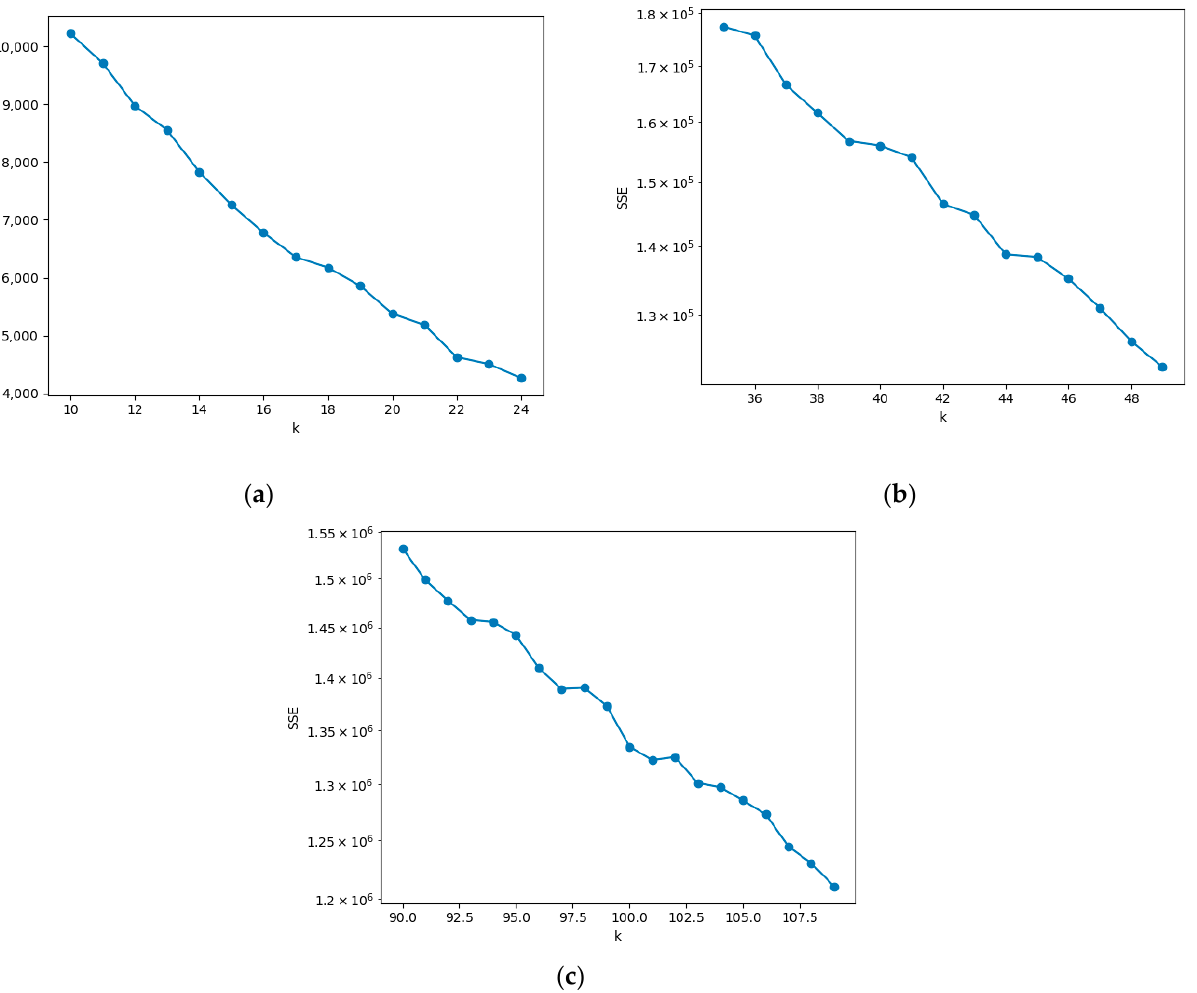
Figure 8. The Elbow method determines the clustering hyperparameter 𝑘 : ( a ) the small network; ( b ) the medium-sized network; ( c ) the large networks.